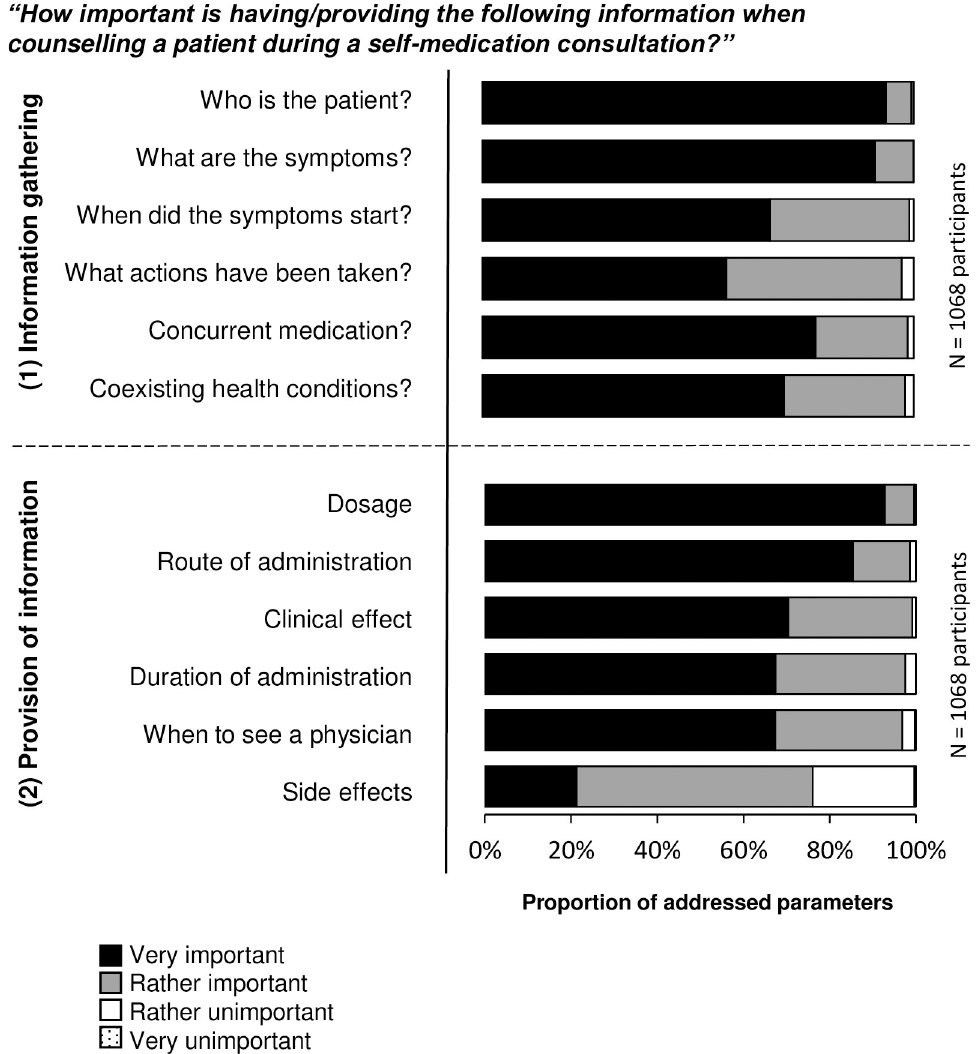
Fig 2. Self-reported levels of importance (I) of the parameters during a self-medication consultation. The twelve parameters were rated by 1067 respondents in the self-report (study part A). One participant did not specify the importance of the